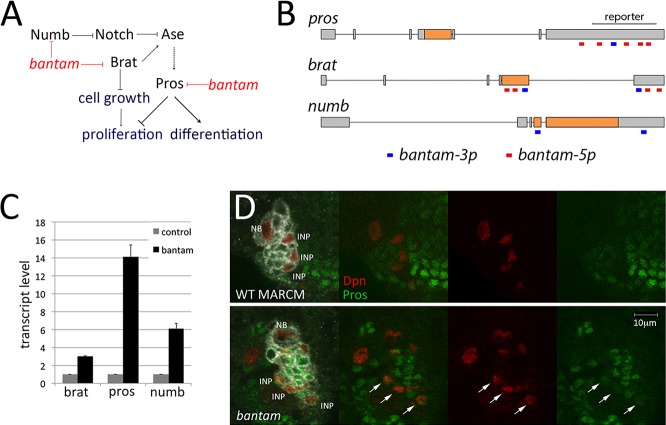
Bantam targets multiple regulators of type II lineage progression. (A) Diagram showing regulators of the type II lineage growth and proliferation, indicating potential bantam targets. (B) Diagram of the prospero, brat and numb transcripts showing predicted target sites for bantam-5p and bantam-3p. (C) Normalized prospero, brat and numb mRNA levels measured by quantitative PCR in RNA isolated from neuroblasts by TU tagging. Data show mean±s.d. of two independent biological replicates. (D) Prospero protein (green) in wild-type (WT) FRT2A and bantamΔ1/Δ1 mutant type II NB clones. NBs and mature INPs were labeled with anti-Dpn (red). The clonal progeny are labeled white in the merged images. Arrows indicate INPs in the bantamΔ1/Δ1 mutant clone expressing Dpn and nuclear Prospero.